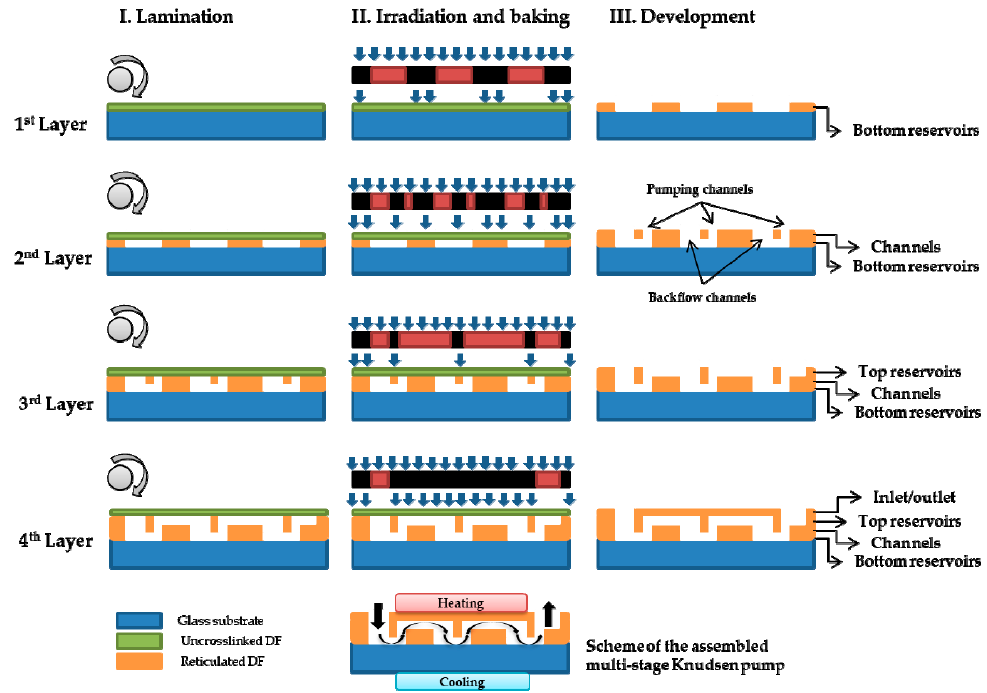
Figure 2. Schematic of fabrication process with the superposition of dry film (DF) photoresist layers and the use of lamination (grey cylinders) and lithography techniques. Typical thicknesses of the DF layers are 5, 25, 50, and 100 µm, while the thickness of the glass wafer is 500 µm. In the cooled reservoirs the glass substrate can be replaced with a silicon substrate to improve temperature uniformity.